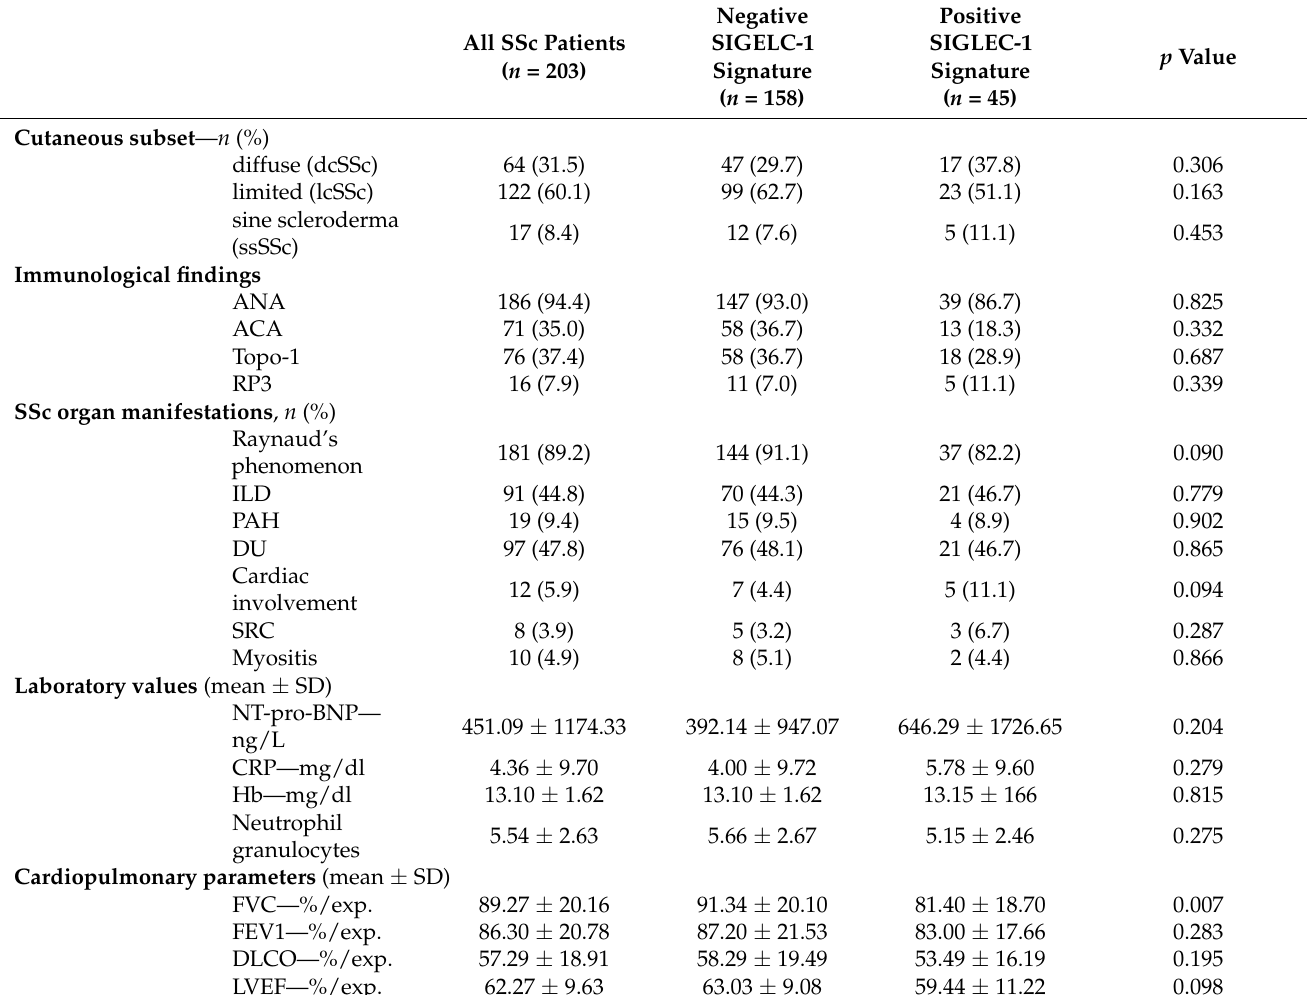
Table 2. Clinical and serologic characteristics of SSc